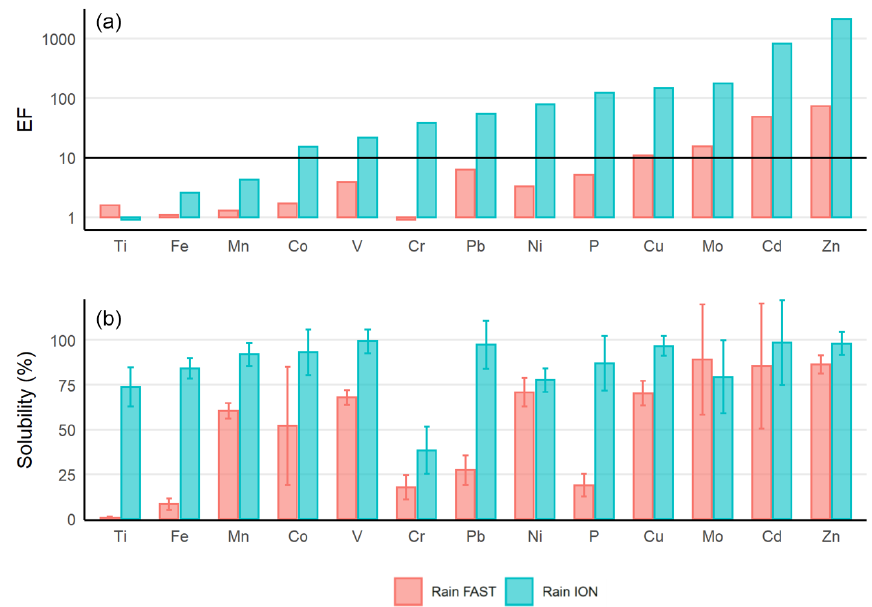
Figure 7. Enrichment factor (EF, a ) and solubility (%, b ) of phosphorus (P) and TMs ordered by increasing EF in the two rainwater